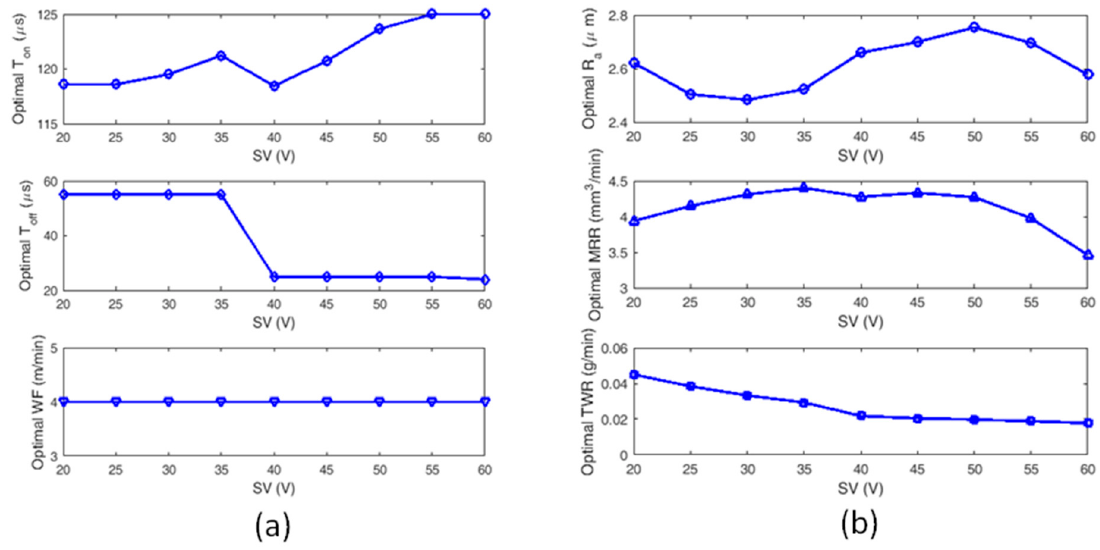
Figure 9. Optimal control factors and output responses for different ranges of SV: ( a ) optimal control factors for different ranges of SV and ( b ) optimal output responses for different ranges of SV.